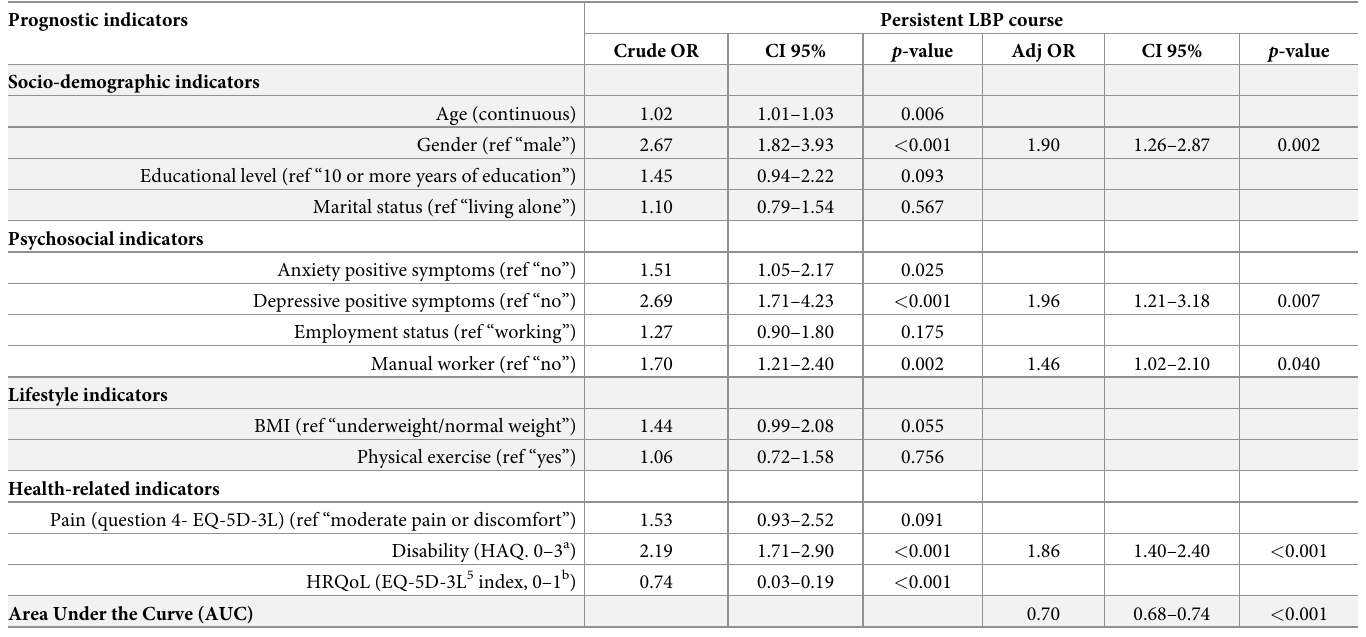
Table 3. Odds Ratio (95% Confidence Intervals) for the associations between prognostic indicators and the persistent course of LBP (n =